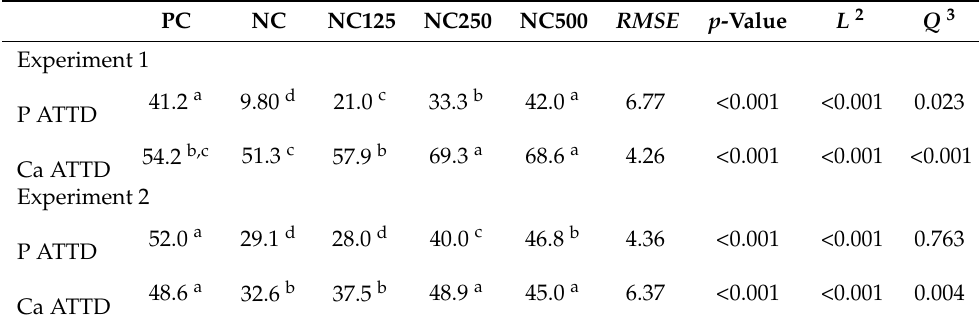
Table 3. Effect of 6-phytase supplementation to negative control diets on Ca and P apparent total tract digestibility (ATTD, %) of the starter diets between 18–21 days 1 .